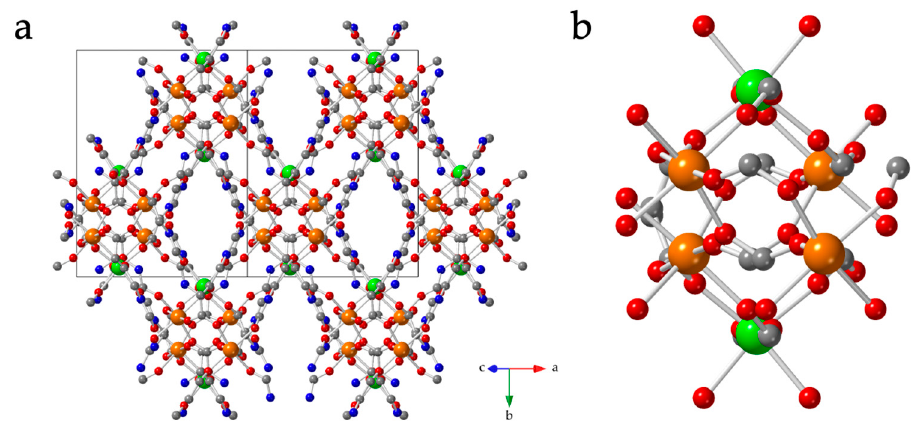
Figure 3. ( a ) Projection of the structure of compound 1 down the [101] direction (perpendicular to the chains). ( b ) View of one isolated chain along the same direction. Colour code: C = gray, O = red, N = blue, Mn1 = green, and Mn2 = orange.